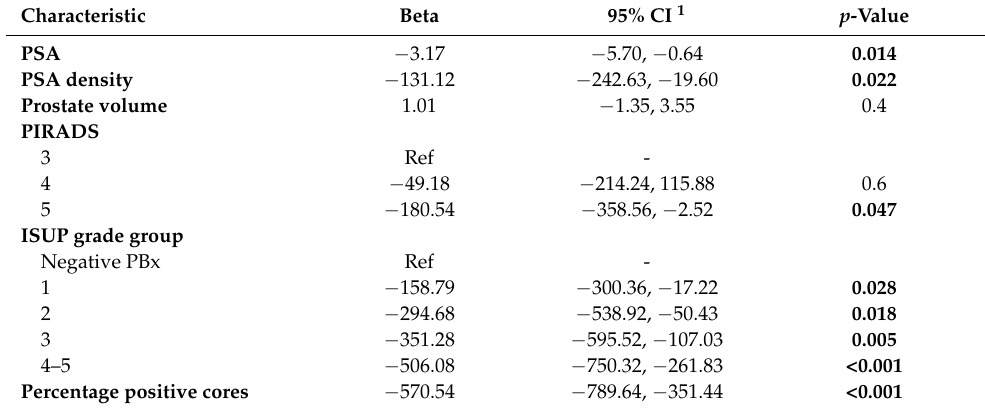
Table 3. Univariable linear regression analyses testing the association between determinant of prostate cancer aggressiveness and peri-prostatic adipose tissue (PPAT)—apparent diffusion coefficient (ADC) values.